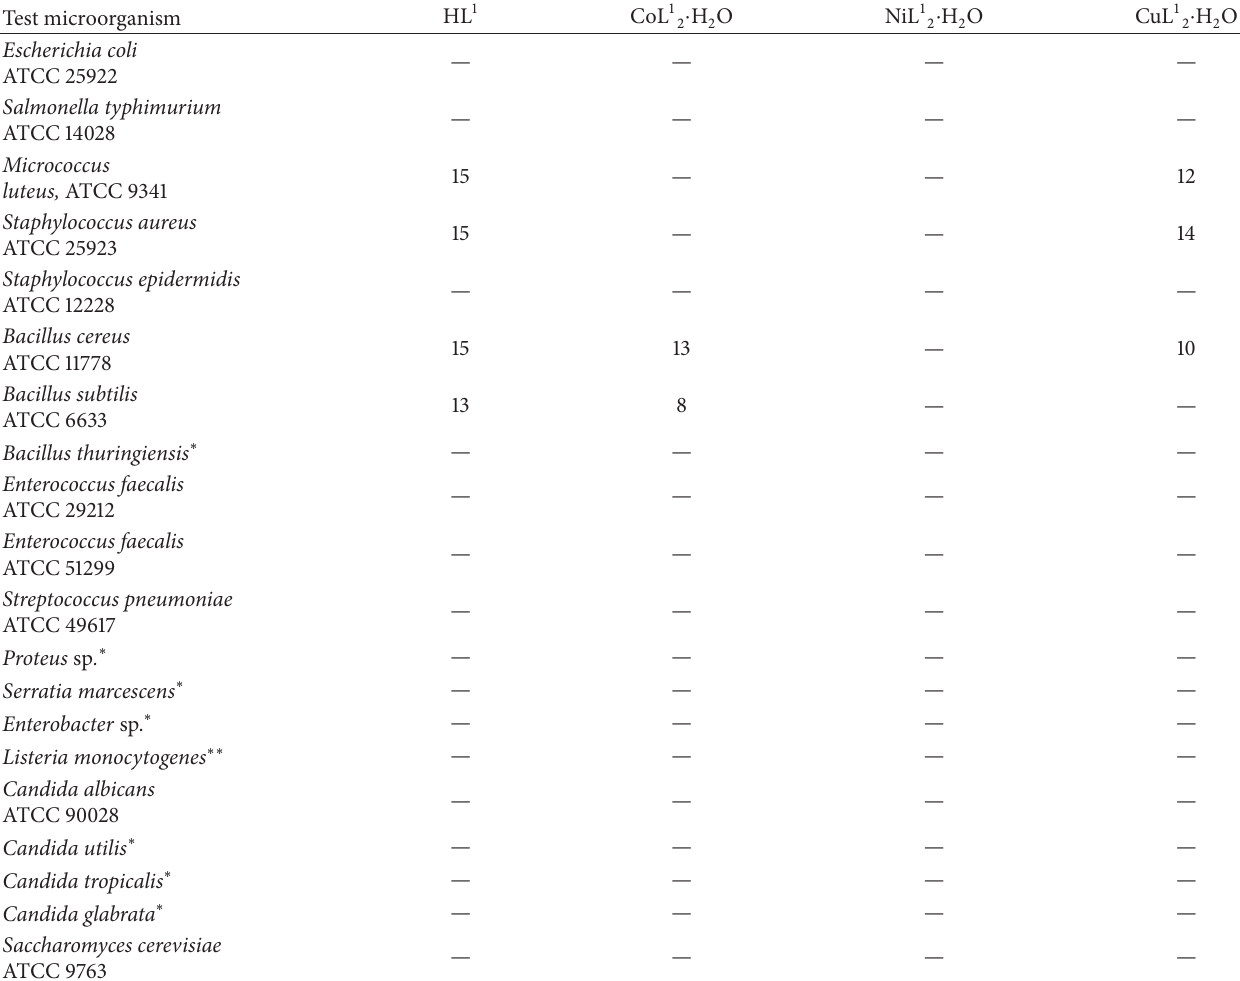
Table 6: Antimicrobial activities of HL 1 and the metal complexes (inhibition zone diameter (mm). Test microorganism